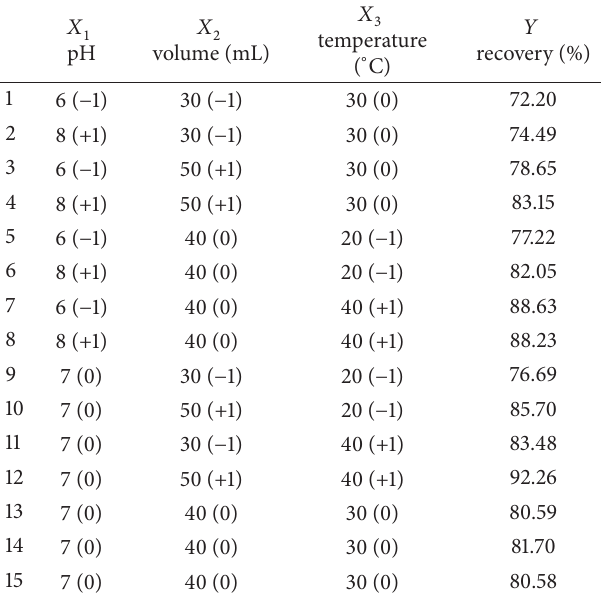
Table 2: Box-Behnken design with actual/coded values and results of tetracycline antibiotics